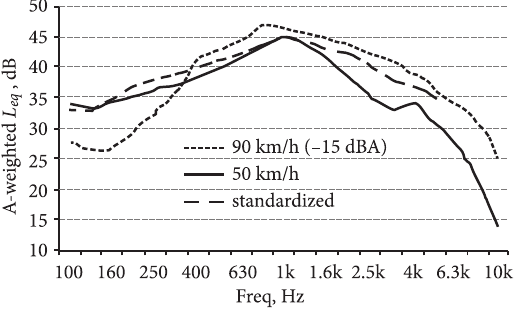
Fig. 4. Equivalent A-weighted spectrum levels of the road traffic noise produced from vehicle passing by at speeds of 50 km/h and 90 km/h (Jagniatinskis, Fiks 2014)